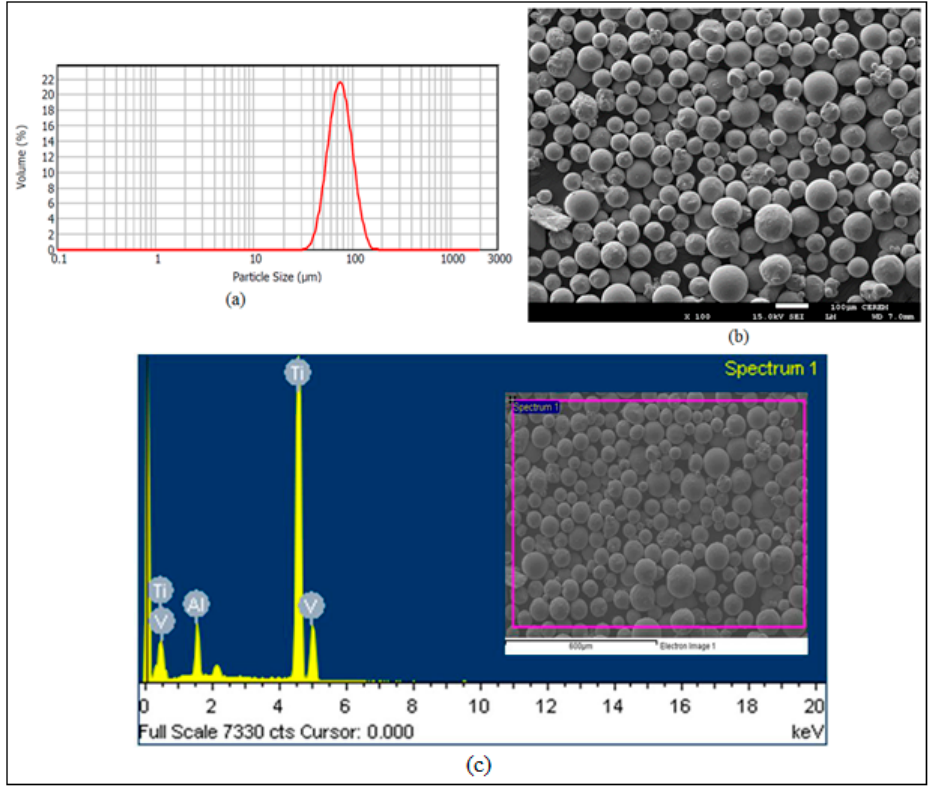
Figure 9. Ti6Al4V ELI: ( a ) particle size distribution; ( b ) SEM image; ( c ) material composition.